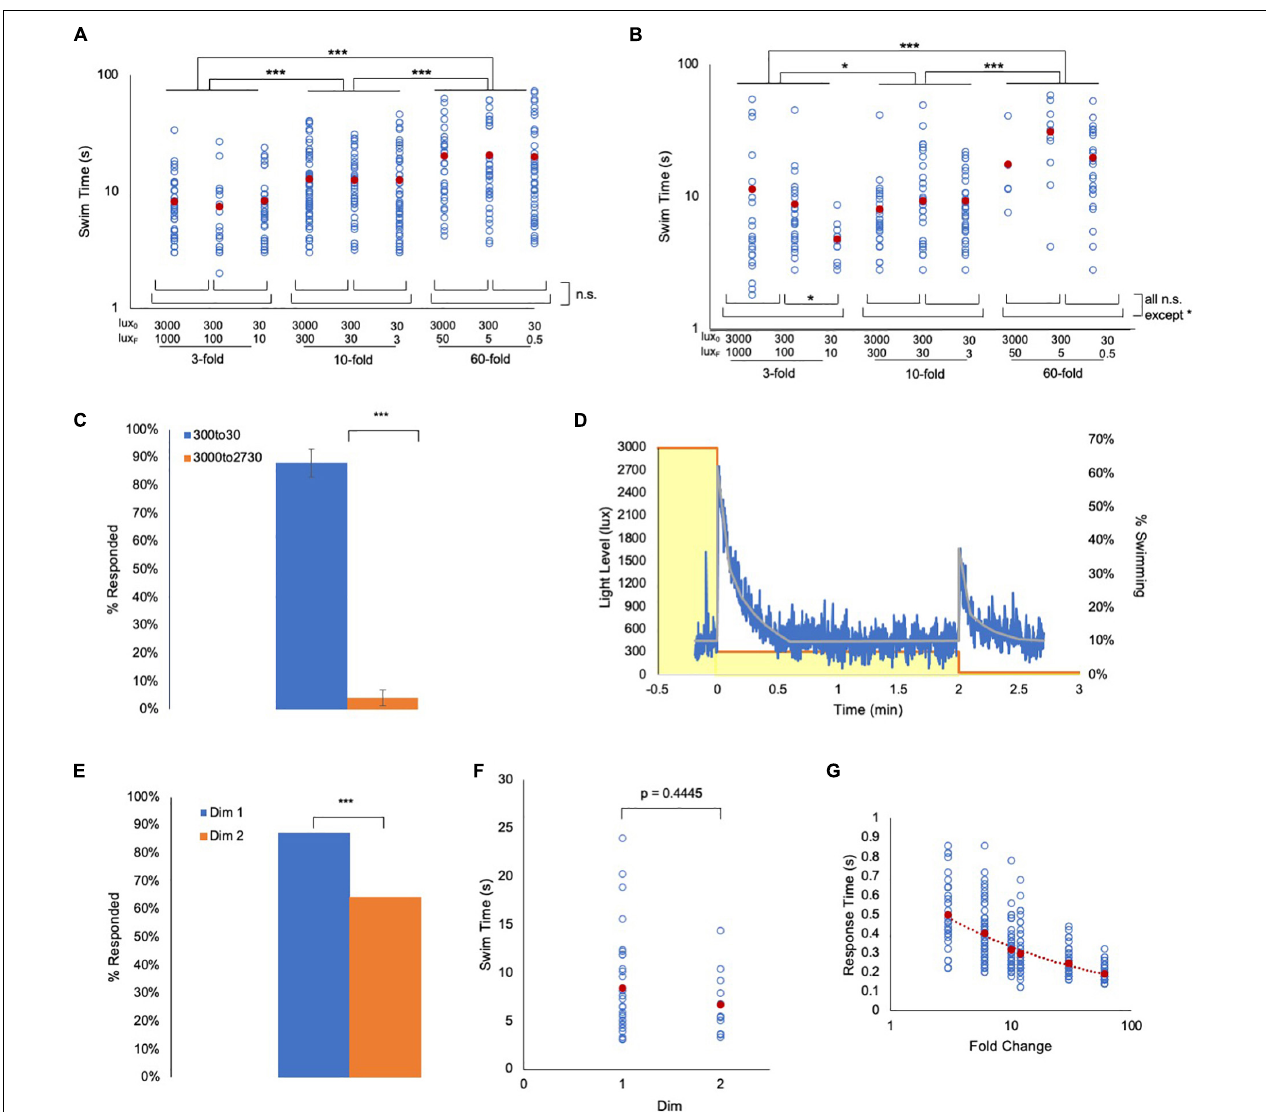
FIGURE 3 | Ciona fold change detection response. (A) Ciona larvae swim times show scale-invariance to light dimming across three orders of magnitude. Lux 0 : initial illumination level in lux; Lux F : illumination after dim in lux (log/log plot shown). (B) Same light-dimming series as in panel A, but with pristine mutants (log/log plot shown). (C) The Ciona light-dimming response follows Weber’s law. Shown are the percent of larvae responding to 270 lux dimming from the initial conditions of 300 lux or 3000 lux ( n = 776 and 443; respectively). (D) Ciona larvae show absolute adaptation to light-dimming. Larvae were exposed to two light dimmings separated by 2 min (3000 lux to 300 lux, and 300 lux to 30 lux; yellow boxes). The blue line shows the percent of larvae swimming at 1 s time intervals ( n = 91–320). The gray line is the average at each time point. See also Movie 2. (E) For data shown in panel (D) , a higher percentage of larvae responded to the 3000 to 300 lux dim (Dim 1) than to the 300 to 30 lux dim (Dim 2). (F) For the experiment shown in panel (D) , the swim times induced by the 3000 to 300 lux dim (Dim 1) were not different from the 300 to 30 lux dim (Dim 2). (G) Plot of the reaction time versus fold change. This is defined as the time point at which swimming was first detected following dimming. For panels (A,B,F,G) , all data points (blue circles) and averages (red circles) are shown. See Supplementary Figure 2 for full data and statistical analyses. (*** = p < 0.001; * = p < 0.05; n.s. = not